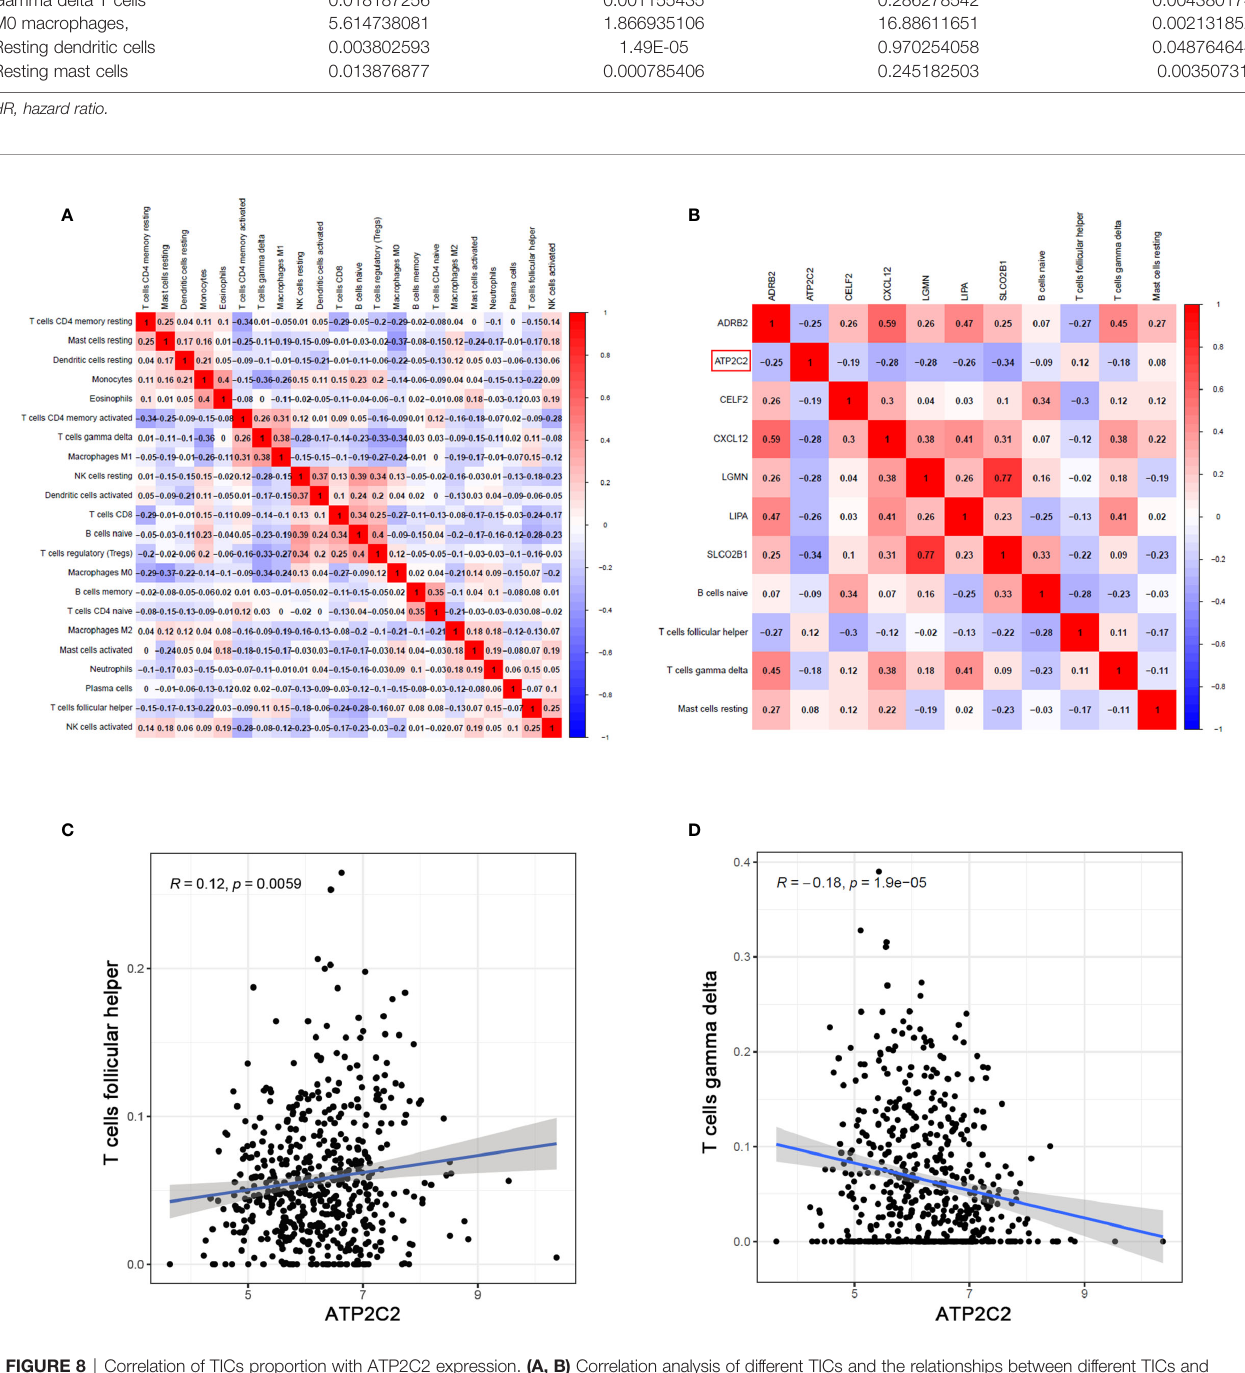
FIGURE 8 | Correlation of TICs proportion with ATP2C2 expression. (A, B) Correlation analysis of different TICs and the relationships between different TICs and DEGs in tumor tissues of BRCA. Pearson ’ s correlation coef fi cient ( r ) was used for the signi fi cance test. (C, D) Correlation between Tfh cells, gd T cells and ATP2C2 expression. Correlation test is conducted by the Pearson coef fi cient. p -value < 0.01 is the signi fi cance